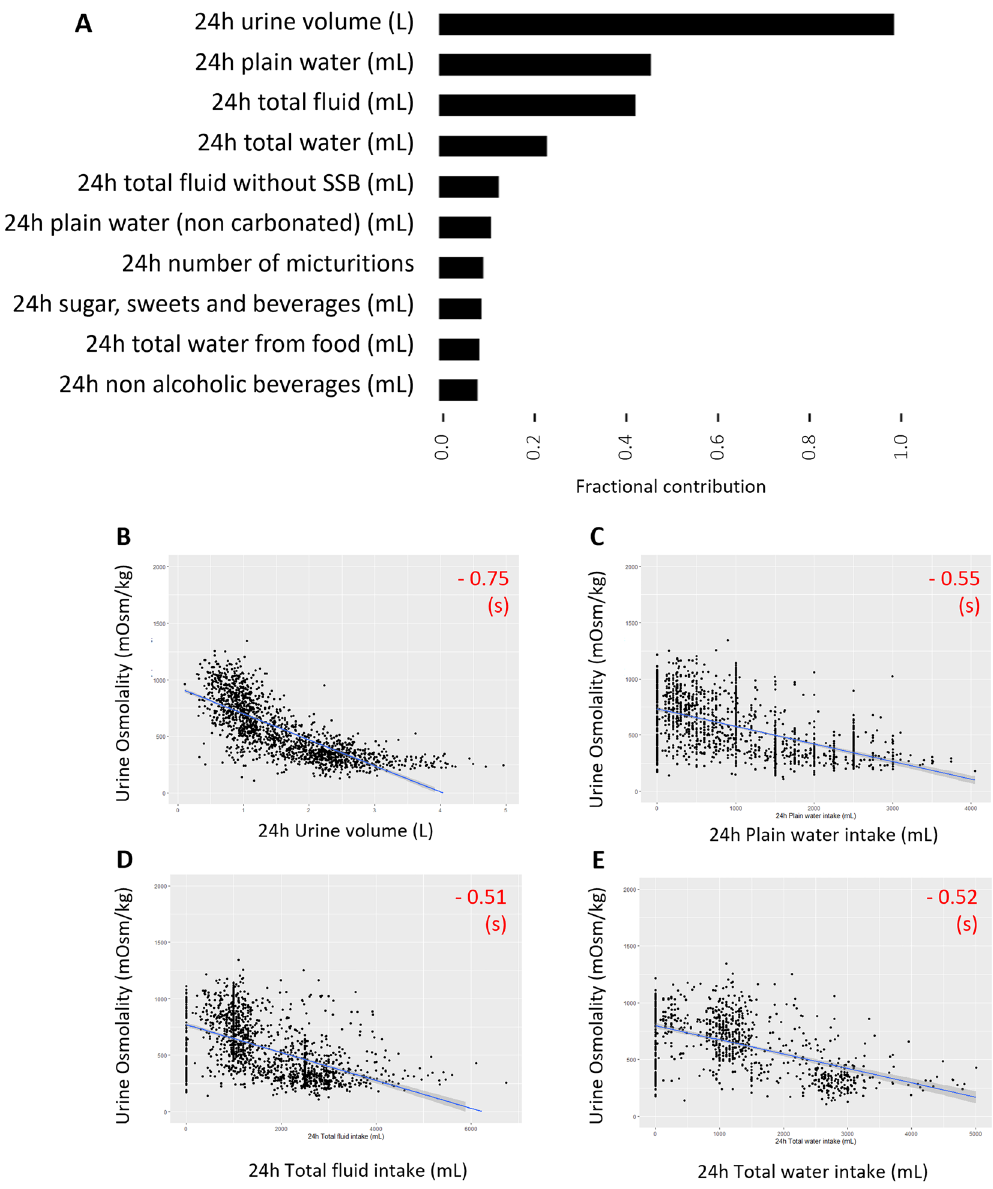
Figure 2. Variable importance to determine U Osm and data distribution. ( A ) Feature importance plot showing the 10 most important features obtained with XGBoost. ( B – E ) Data distribution of Urine osmolality against 24 h Urine volume (n = 1575), Plain water intake (n = 1404), Total fluid intake (n = 1468) and Total water intake (n = 1448). Pearson’s correlation coefficient; (s) significant, (ns) non-significant based on linear regression p-value (< 0.05). The R ggplot2 package was used to generate the figures https:// ggplo t2. tidyv erse. org. R Statistical Software version 3.6.3 (R Core Team https:// cran.r- proje ct. org/ bin/ windo ws/ base/ old/3.